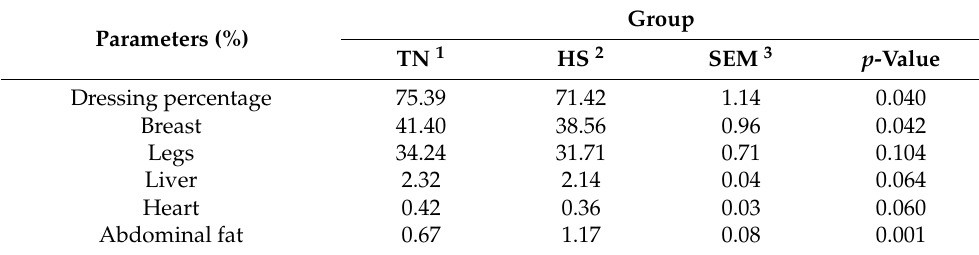
breast ( p = 0.003, 0.002 and 0.001, respectively) and thigh ( p = 0.001, 0.009 and 0.003, re- spectively) muscles than did the TN group. The concentrations of α -linolenic acid in the breast and thigh muscles did not differ between both experimental groups ( p = 0.818 and 0.060, respectively). Table 1. Effect of chronic heat stress on carcass traits of broiler chickens. Group Parameters (%)